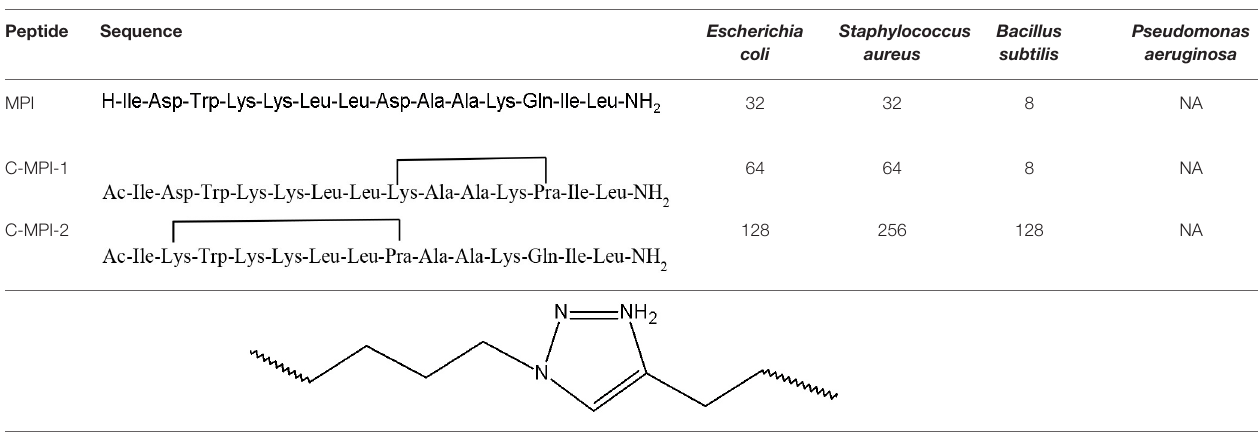
TABLE 3 | Amino acid sequence and antibacterial activities of MPI and its analogues with MIC values given in µ M (NA, no antimicrobial activity) (Liu et al., 2017b). Peptide